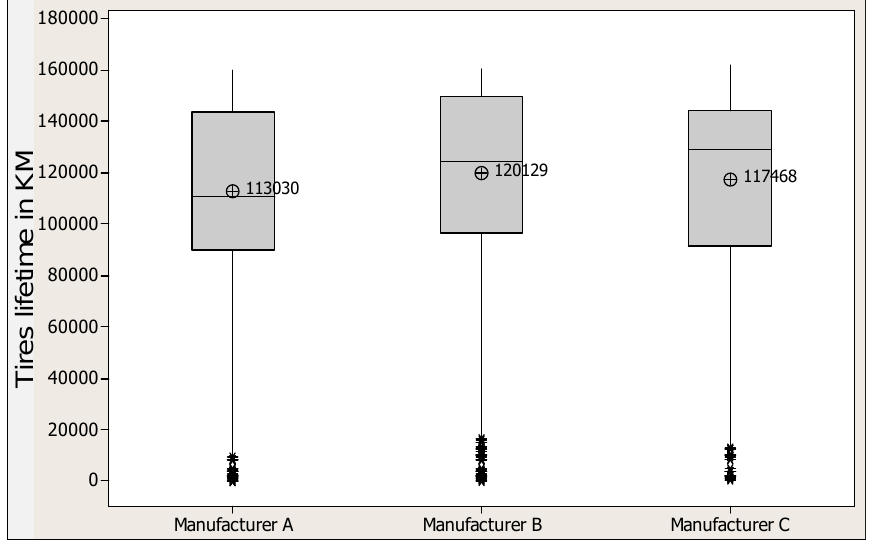
Figure 2 – Analysis of lifetime of tires based on